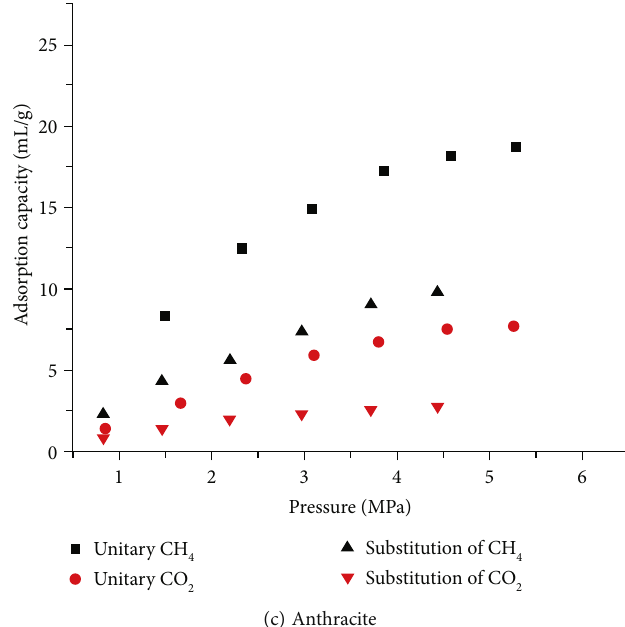
Figure 4: Adsorption capacity of lignite, bituminous coal, and